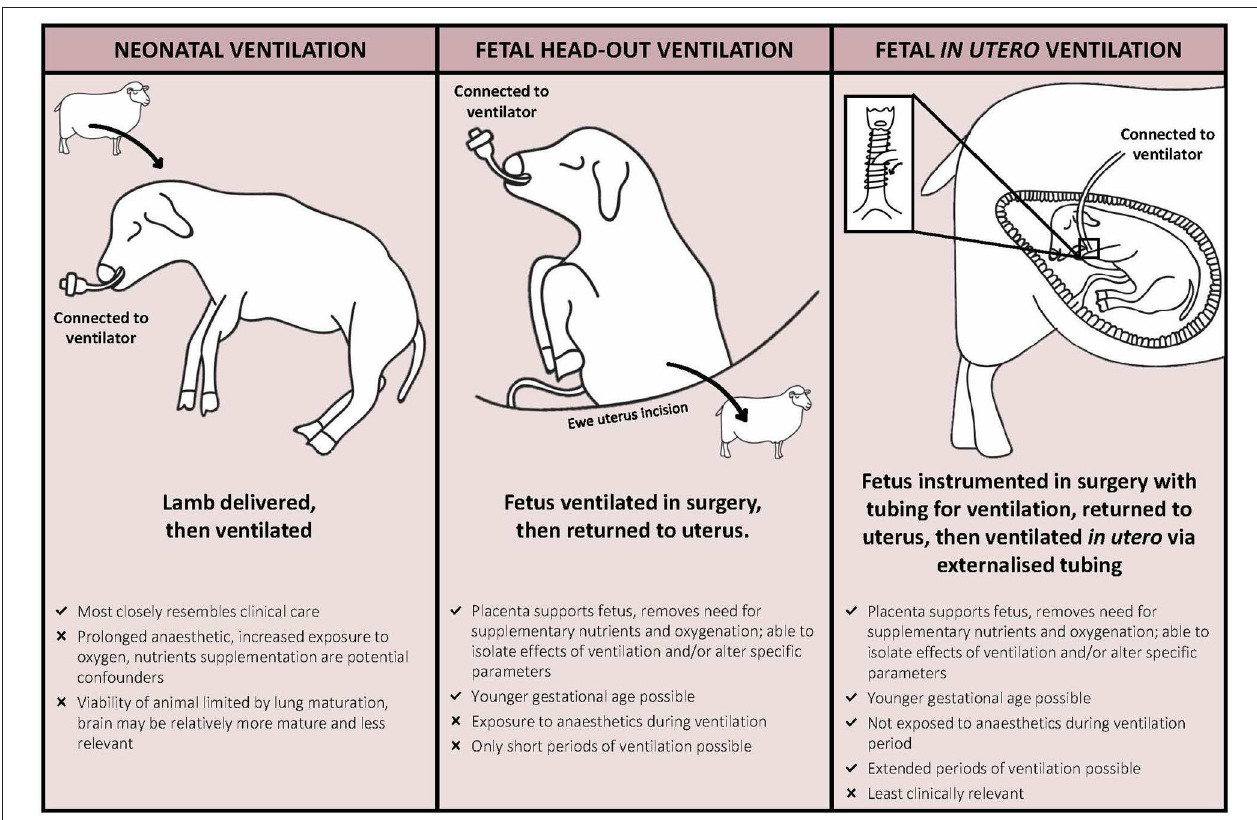
FIGURE 1 | Experimental models of ventilation-induced injury in sheep outlining the major advantages and disadvantages of each model.